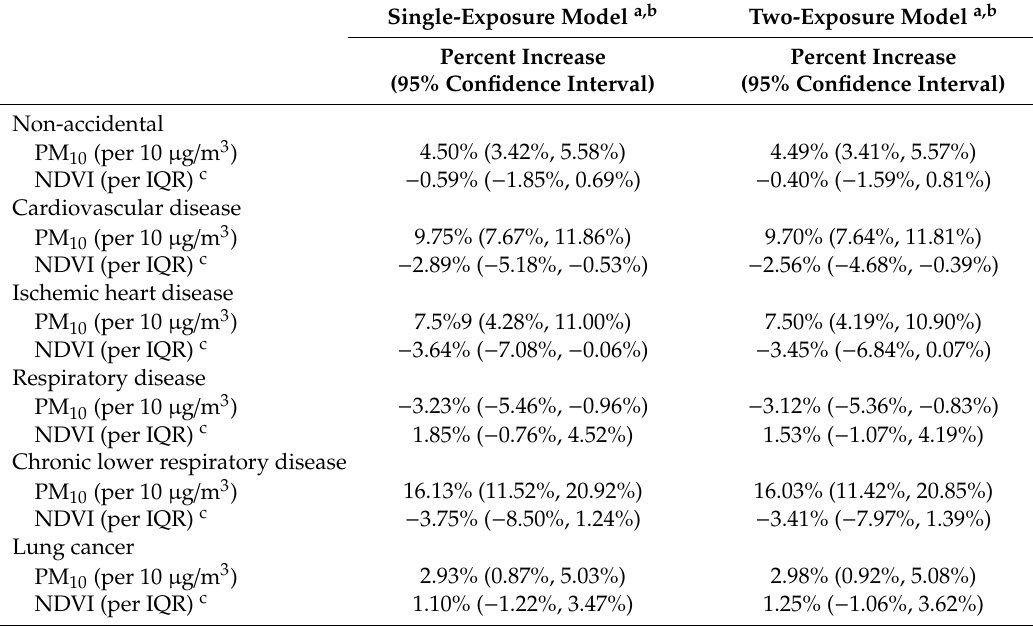
Table 2. Percent changes in cause-specific mortality and 95% confidence interval for 10 µ g / m 3 increase in PM 10 and interquartile range (IQR) increase in